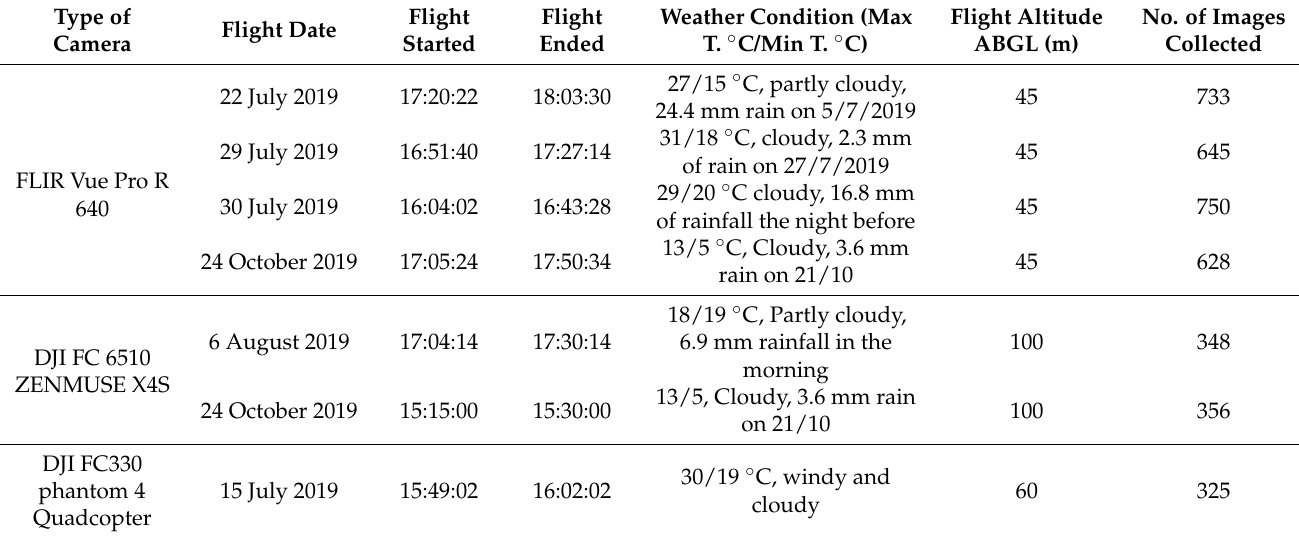
Table 2. Detailed flight information during data collection, study site was covered with soybean crop for all flights except for the flight conducted after harvesting on 24 October